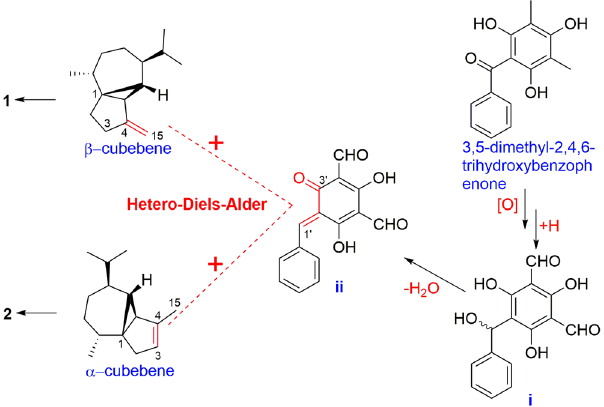
Figure 13. A plausible biosynthetic pathway of 1 and 2 .